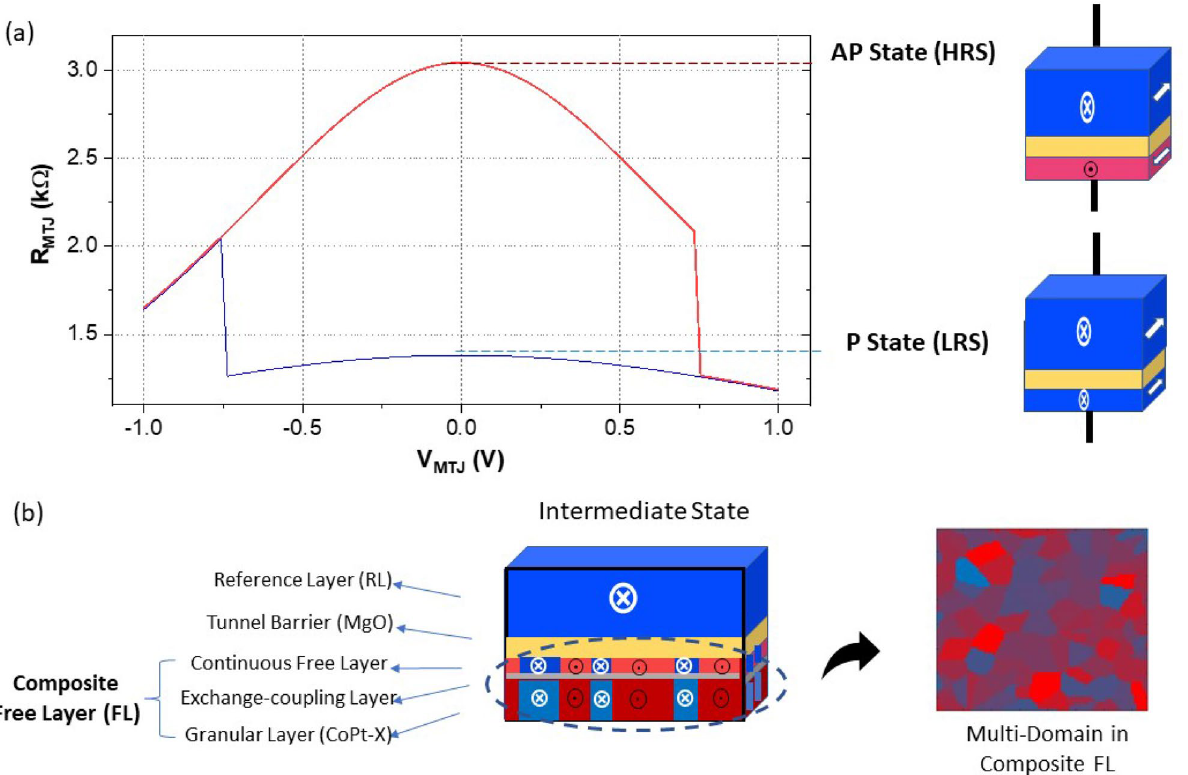
Figure 1. ( a ) High and low resistance states of an MTJ under voltage sweeps. The MTJ switches between parallel state (P) and anti-parallel (AP) state due to STT. The MTJ current–voltage characteristics are from device conductance modeling based on non-equilibrium Green’s function (NEGF) formalism 28 . ( b ) Device structure of the proposed MTJ with an exchange-coupled free layer. Multi-domain magnetization is induced by the granular layer in the composite free